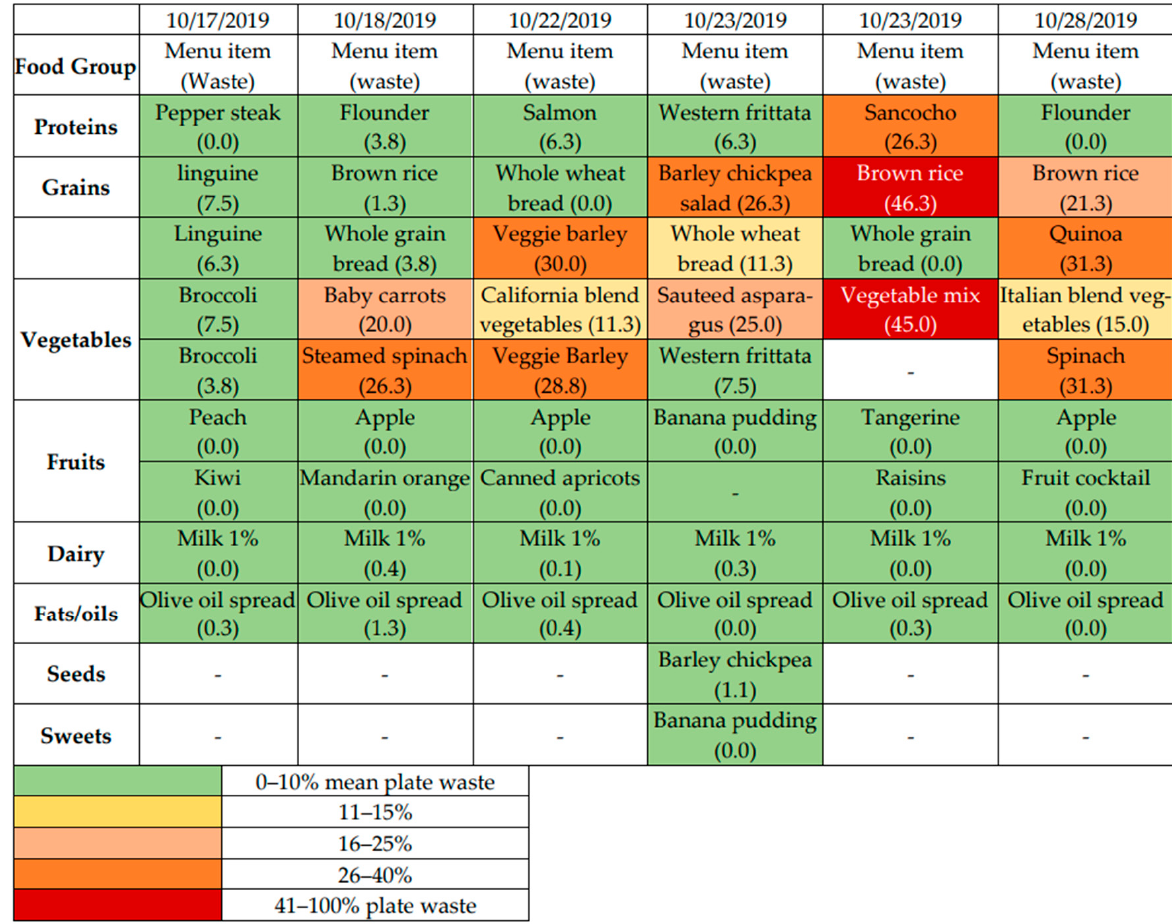
Figure 3. Plate Waste. The average plate waste (% of the component left on the plate) for 20 assessed plates at a given meal is shown for each meal (shown in columns, by date) and broken down into DASH meal components (rows) of proteins, grains, etc. The specific menu item served at each meal is included. The colors represent low (green) versus high (red) levels of plate waste as indicated in the legend